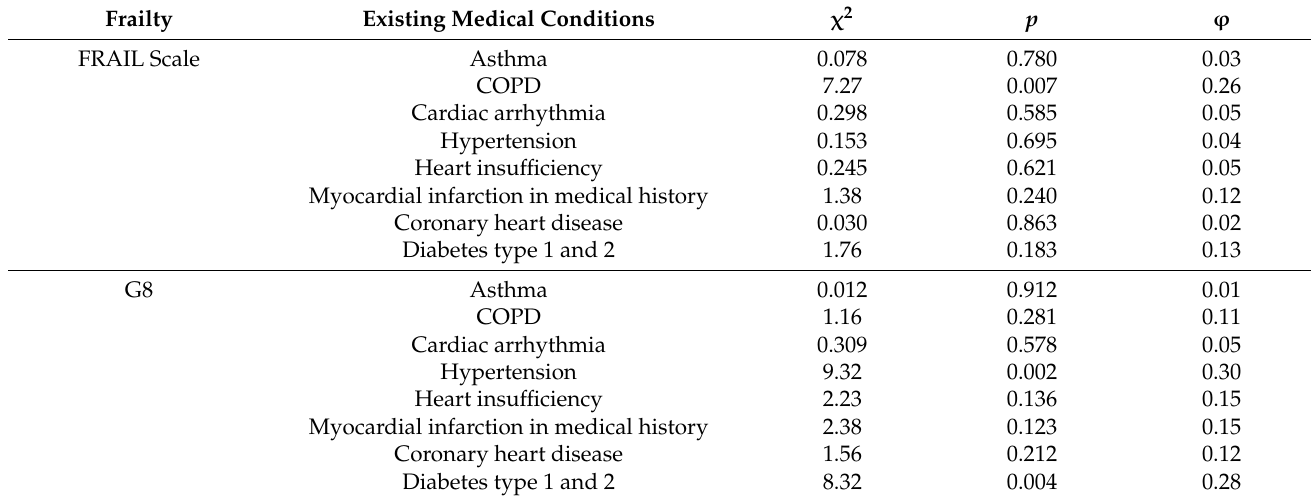
Table 4. χ 2 test for presence of frailty and existing medical